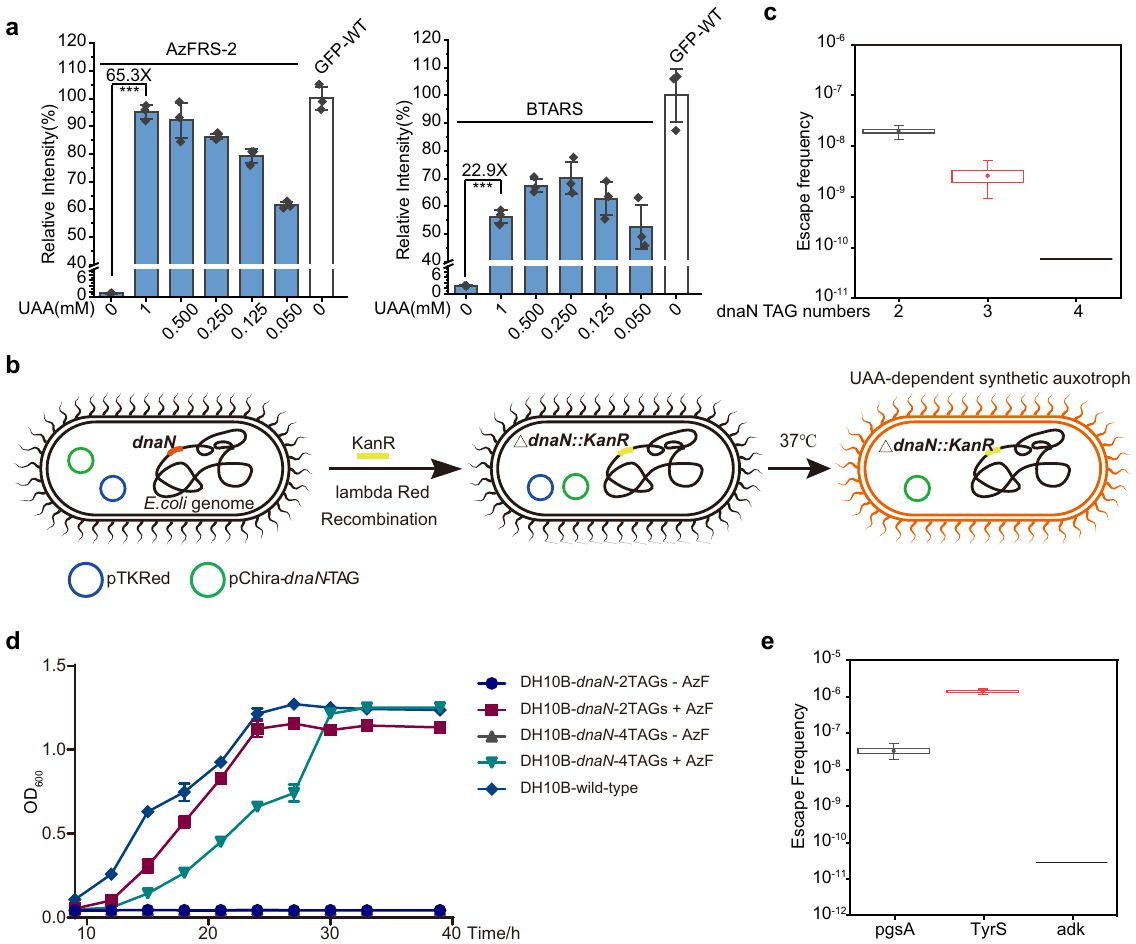
Fig. 5 Construction of UAA-dependent synthetic auxotroph. a Amber suppression ef fi ciency of the AzF system and the BTA system is tested in the presence of indicated concentration of AzF or BTA. Statistical signi fi cance is quanti fi ed with one-way ANOVA (*** p < 0.001, p = 5.74E – 7 and 4.24E – 6, respectively). b Schematic illustration of the procedure of engineering UAA-dependent synthetic auxotroph. The pTKRed vector carries the lambda Red recombinase system, and the pChira vector carries AzFRS-2 (under the control of oxb20 promoter), 3C11-chPheT (under the control of lpp promoter), and the dnaN -TAG gene (under the control of tac promoter). c Escape frequencies of E. coli strains at day 14 post-plating with indicated numbers of TAG in the dnaN gene. The black line represents escape frequency below the detection limit. d Growth curve of various UAA-dependent synthetic auxotrophs in the presence or absence of AzF. e Escape frequencies of E. coli strains at day 14 post-plating with three TAGs in the indicated genes. The black line represents escape frequency below the detection limit. Error bars represents ±standard error of the mean from three biologically independent experiments. The box plots showing the minima, maxima, center, bounds of box and whiskers and percentiles. Source data are provided as a Source Data